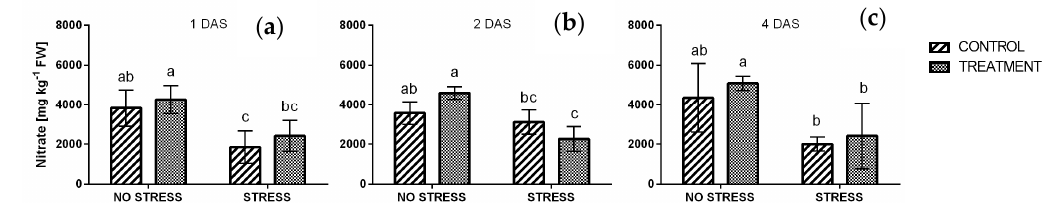
Figure 7. Nitrate concentration in rocket leaves treated with water (CONTROL) and with borage extract (TREATMENT) and subjected to salt stress (200 mM). Measures were taken after one day ( a ), two days ( b ) and four days ( c ) of stress. Values are means ± SE ( n = 4). Data were subjected to two-way ANOVA. Different letters, where present, represent significant differences ( p < 0.05).